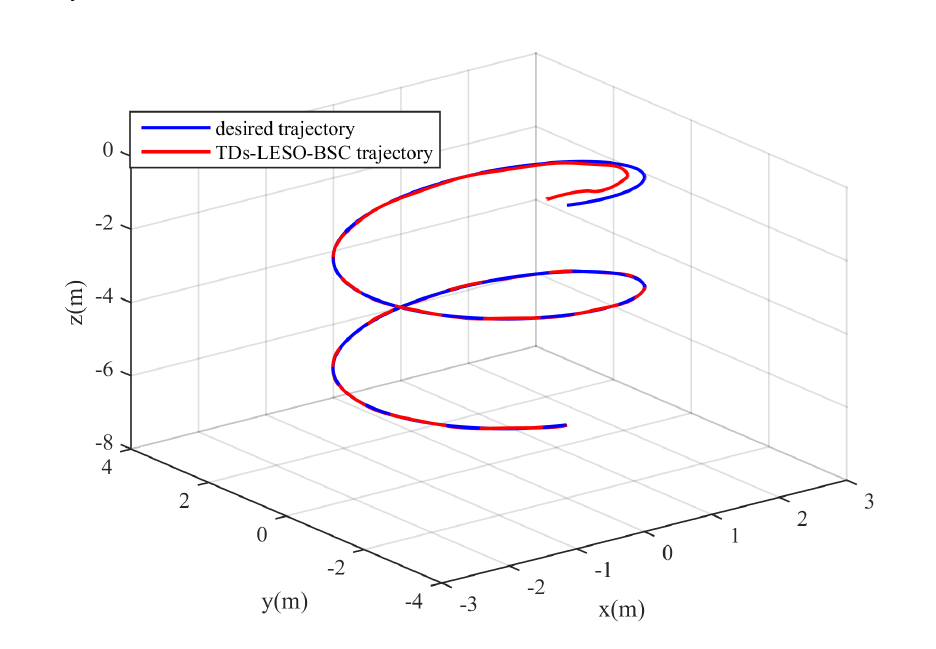
Figure 10. The trajectory considered in